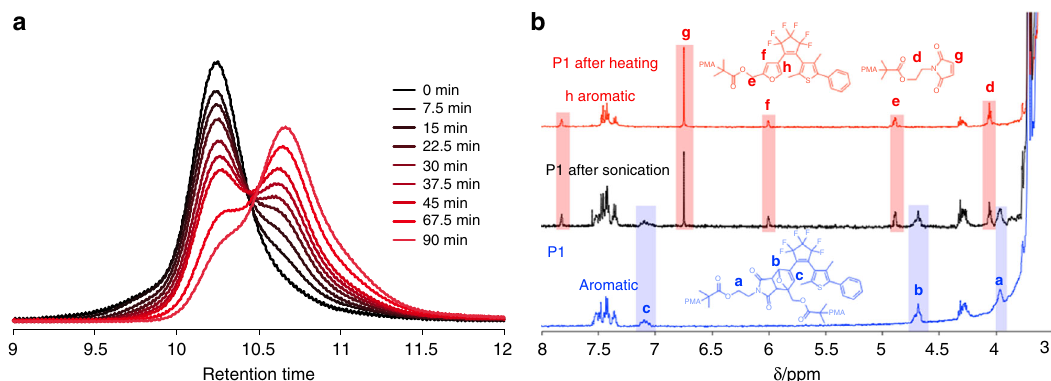
Fig. 4 Mechanical retro-DA reaction of P1 . a SEC curves for P1 upon sonication. A 2 mg mL – 1 polymer solution was exposed to pulsed ultrasound (10.6 W cm – 2 ) under an atmosphere of argon in an ice bath. b 1 H NMR spectra of P1 before and after sonication (45 min), as well as after heating (3 h), showing the products of the retro-DA reaction (Supplementary Fig. 4)